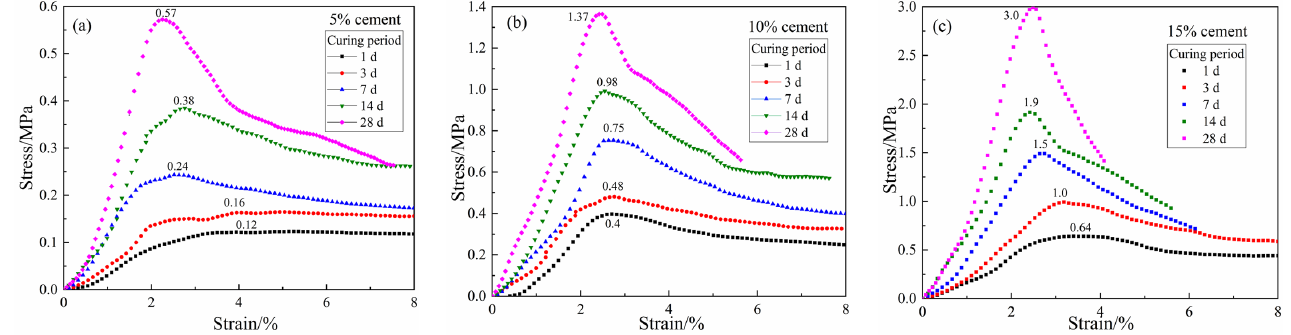
Figure 11. Stress–strain curves of CDS: ( a ) 5% cement content, ( b ) 10% cement content, ( c ) 15% cement content.